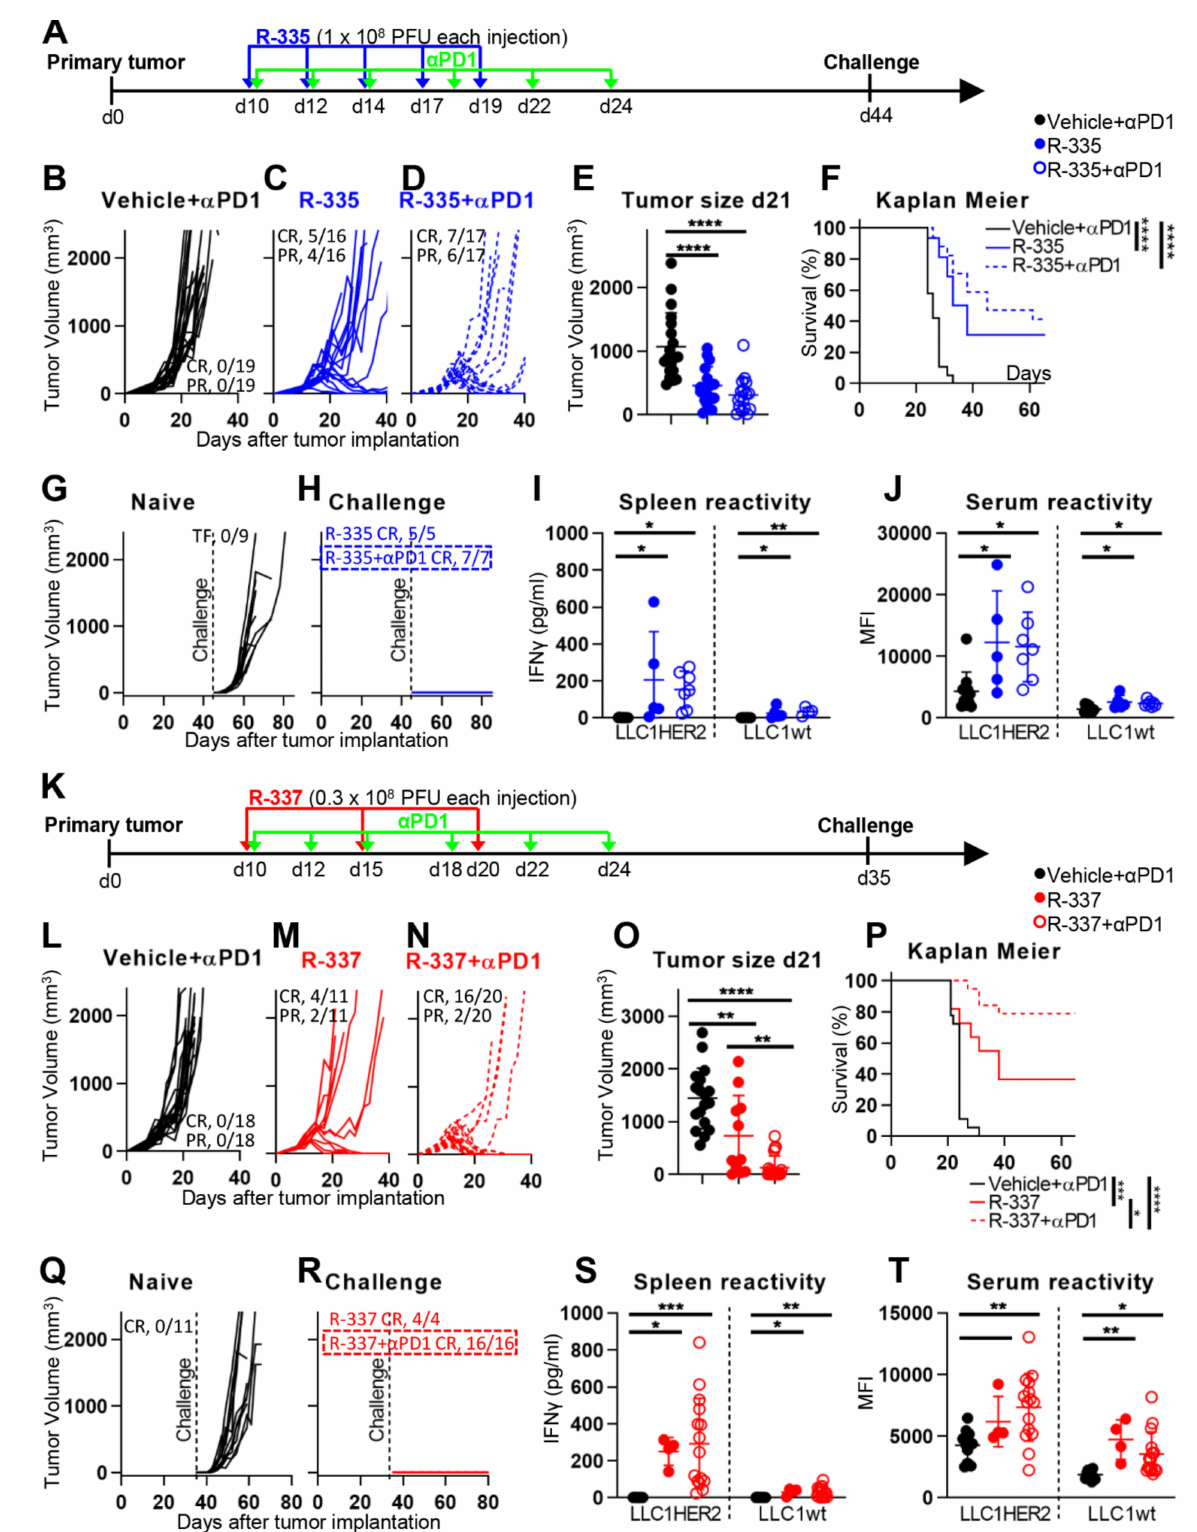
Figure 6. Efficacy of R-335 of R-337 in combination with anti-PD1 antibodies on the growth of LLC-1-HER2 tumors. ( A ) Schedule of the treatments. The HER2-TG C57BL/6 mice were implanted with LLC-1-HER2 cells. At d 10 after implan- tation, when tumors reached the average volume of 70–100 mm 3 , mice received 5 i.t. injections of R-335, or R-335 plus i.p. injections of anti-PD-1, at 2–3 days intervals. The administration schedule of oHSV and anti-PD-1 treatments was according to [62–65]. At d 44, the mice which survived the primary tumor received a contralateral challenge LLC-1-HER2